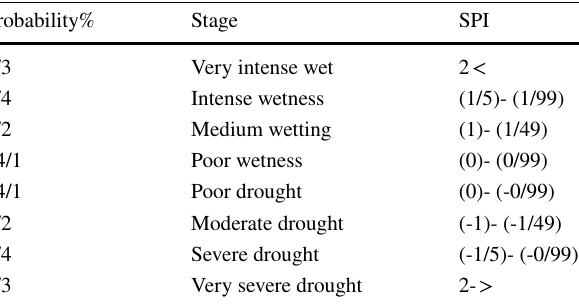
Fig. 1 Spatial distribution of stations with elevation distribution of northwestern region of Iran Table 1 Classification of drought by SPI quantity and the probability of that happening (Edward and Mckee, 1997)